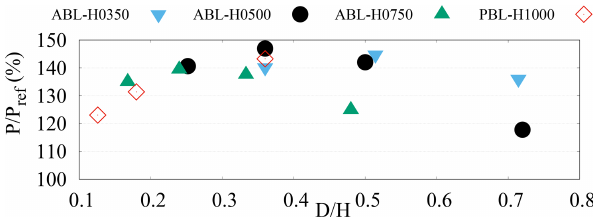
Figure 6. Power gains versus turbine-diameter-to-boundary-layer- height ratio D/H for all considered D – H combinations for the con- trolled cases with rotors tilted by ϕ = 30 ◦ and operated at C (cid:48) Data from C2020 obtained in the PBL are also reported for compar-